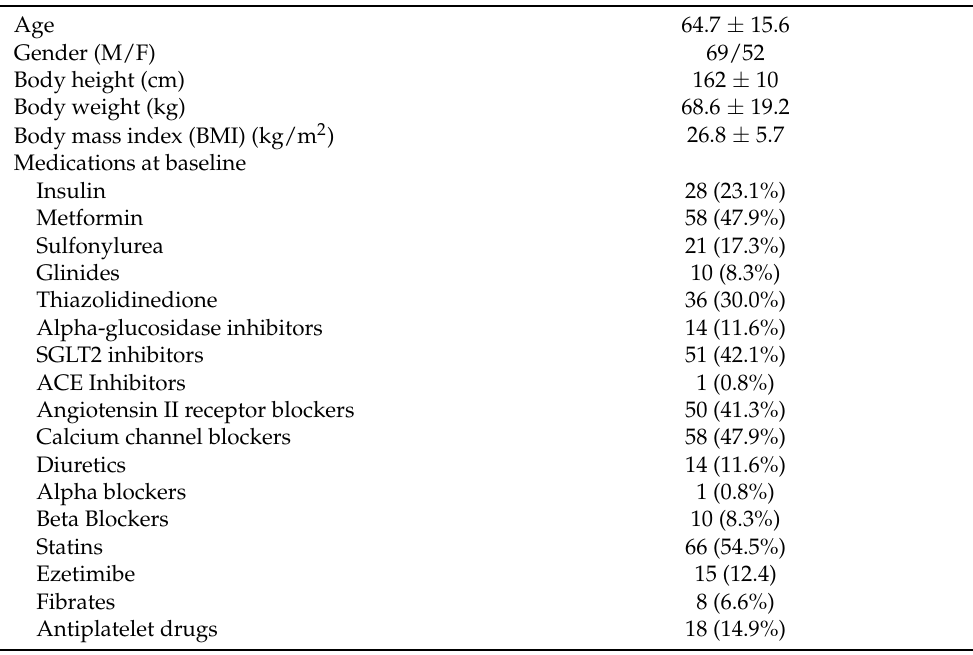
Table 1. Baseline characteristics of the patients (n =